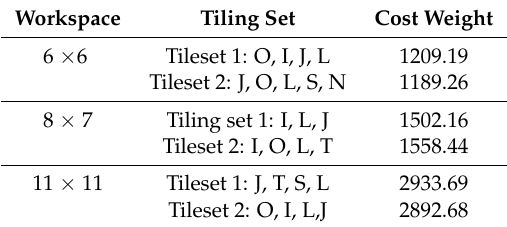
Table 7. Cost weight comparison between tiling sets for one